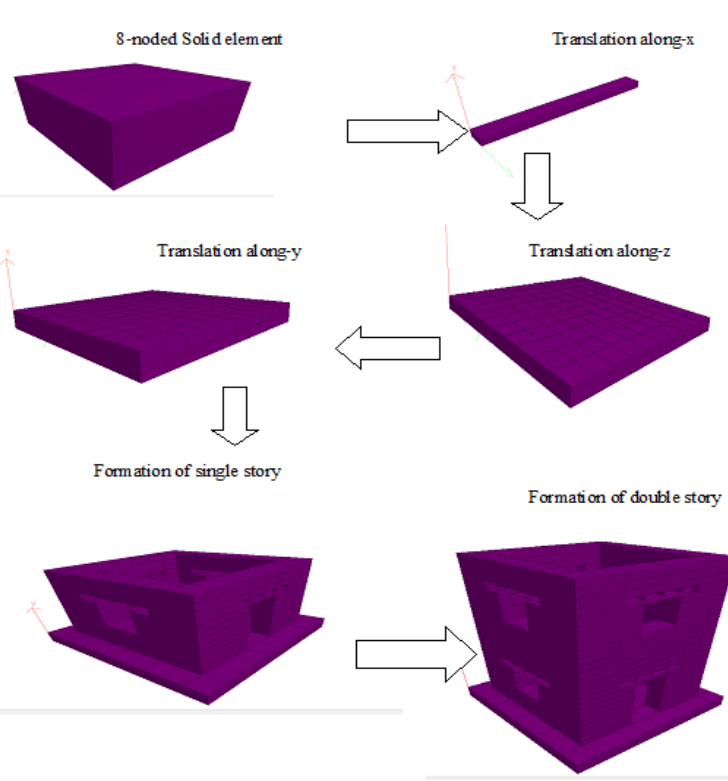
Figure 3 : Step by step formation of mud house